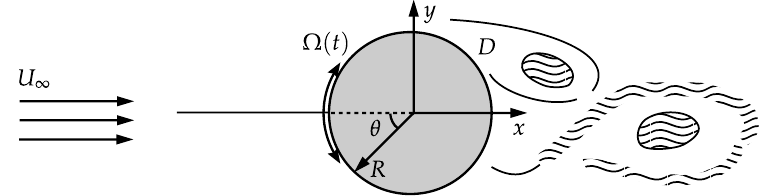
Figure 1. A rotary oscillating cylinder in a